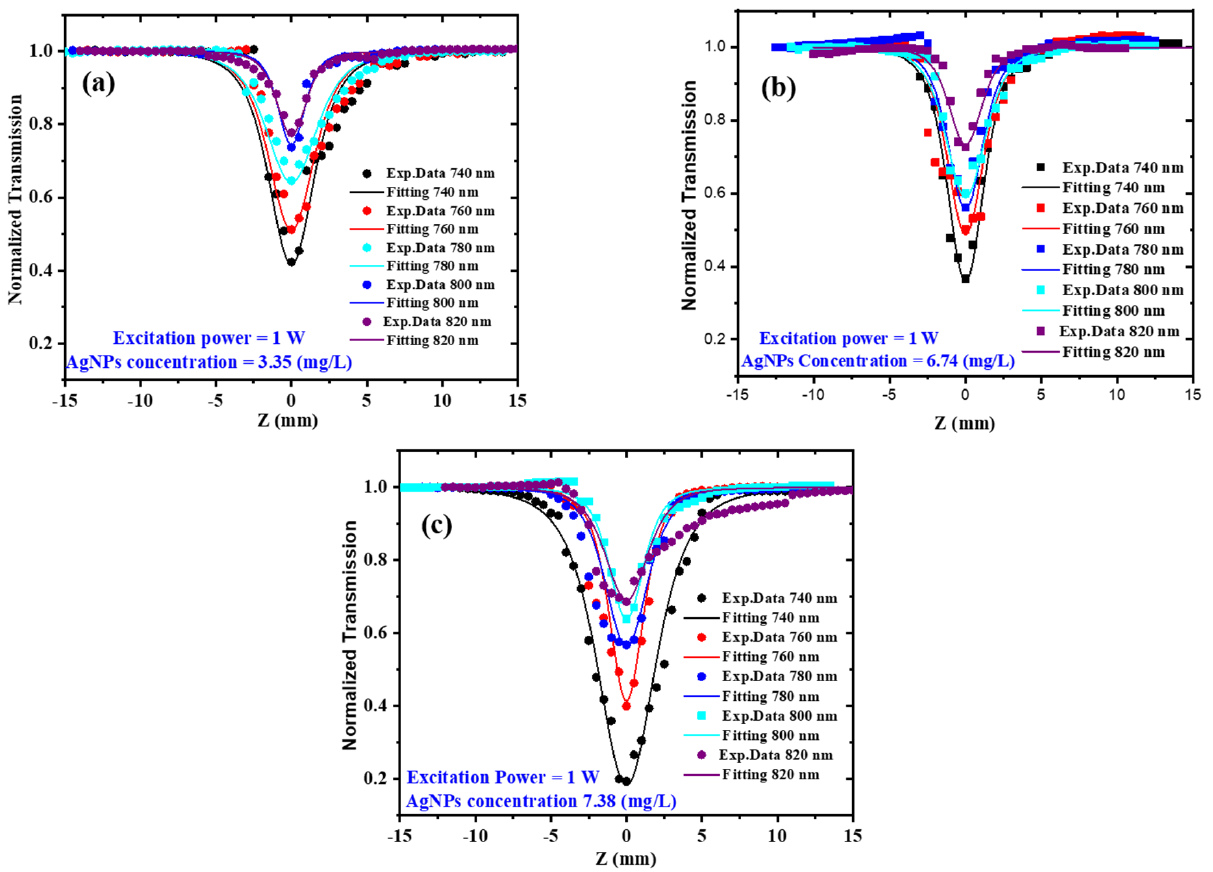
Figure 8. OA Z ‐ scan measurements for AgNP colloids at constant excitation power of 1 W, different excitation wavelengths ranging from 740 to 820 nm, and at different AgNP concentrations of ( a ) 3.35 mg/L, ( b ) 6.74 mg/L, and ( c ) 7.38 mg/L.